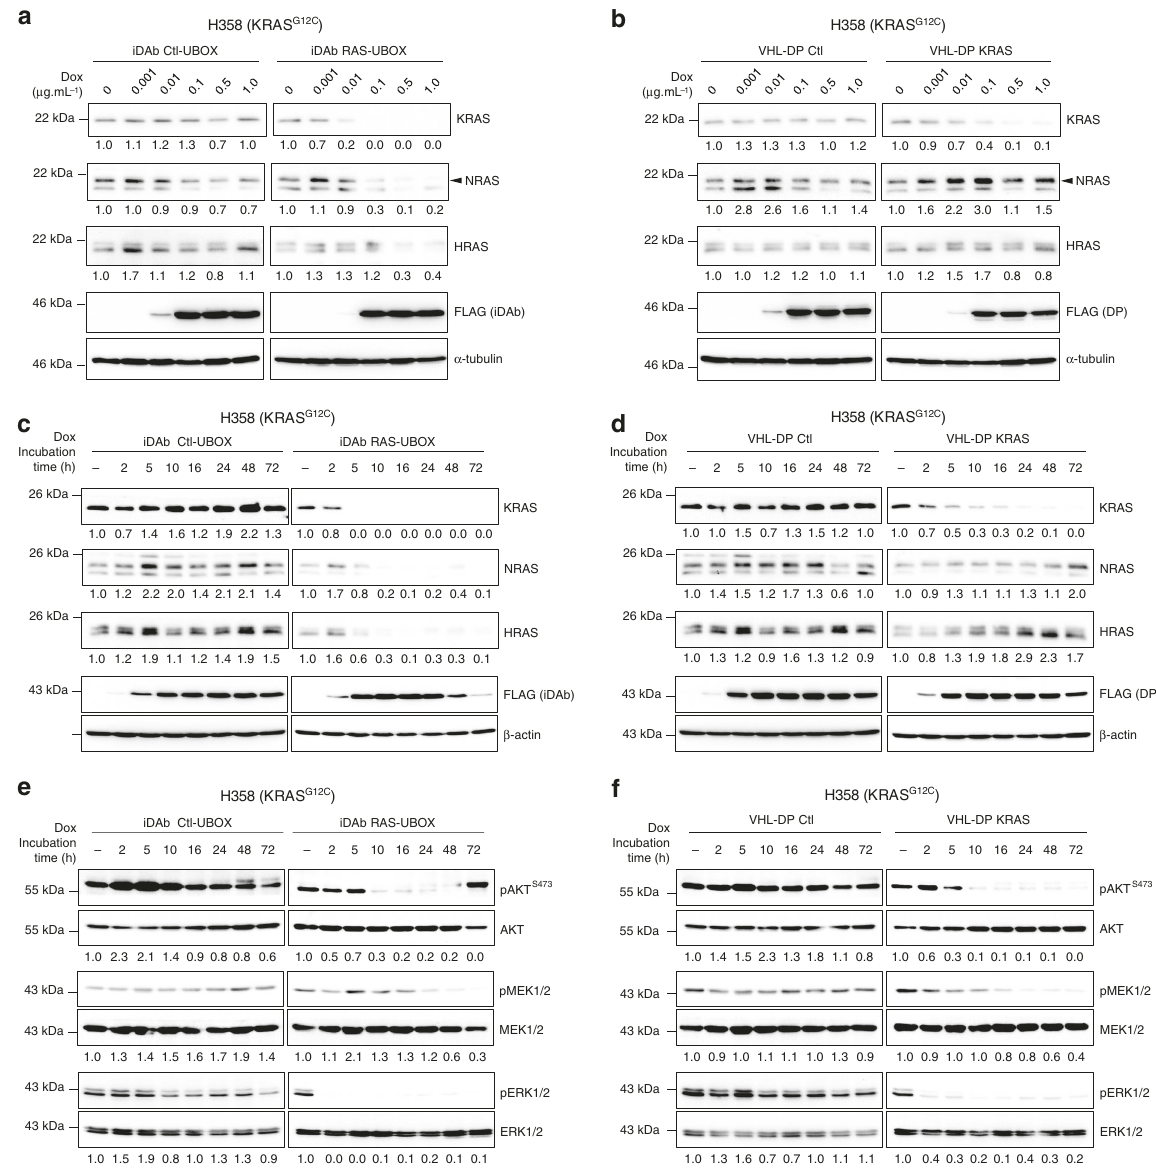
Fig. 2 Characterisation of pan-RAS and KRAS degraders in H358 cancer cells. Western blot of RAS and effectors protein levels following induction of the macrodrug degraders for dose response and time course analysis. a , b Dose response experiment with the indicated doxycycline (dox) concentrations incubated for 18 h in H358 cells expressing either iDAb Ctl-UBOX or iDAb RAS-UBOX ( a ), VHL-DP Ctl or VHL-DP KRAS ( b ). KRAS, NRAS and HRAS protein levels were assessed by Western blot. FLAG antibody shows the expression of the constructs and α -tubulin is the loading control. The black arrowhead shows the speci fi c band corresponding to NRAS protein in the observed doublet. c , d Time response experiment of H358 cells expressing the same degraders as in a , b . Effect of the pan-RAS ( c ) and KRAS degraders ( d ) on KRAS, NRAS and HRAS protein levels was determined using β -actin as the loading control. a – d α -tubulin/ β -actin-normalised KRAS, NRAS and HRAS abundance values are reported beneath individual lanes. e , f Effect of the pan- RAS ( e ) and KRAS degraders ( f ) on RAS dependent pathways was assessed and the β -actin loading control is the same as in panels c , d as the panels were split for clarity purpose. Quanti fi cations of pAKT S473 /AKT, pMEK/MEK and pERK/ERK signals normalised to the no dox ( − ) condition are shown underneath individual lanes. Each experiment was performed twice. a – f Source data are provided as a Source Data fi